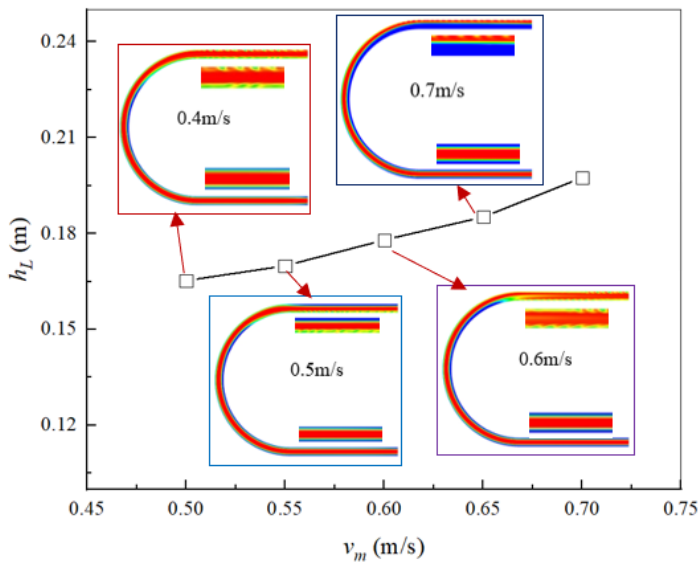
Figure 12. The head loss and the oil–water core–annular flow in the return bend ( v o = 0.6 m/s).